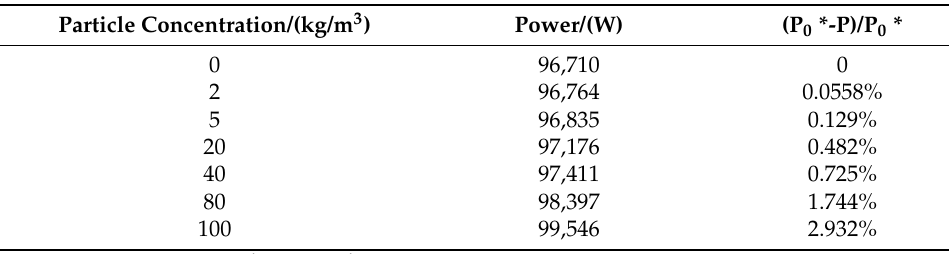
Table 8. The power of the 120 kW tidal current turbine at different particle concentrations when the particle diameter is 20 µ